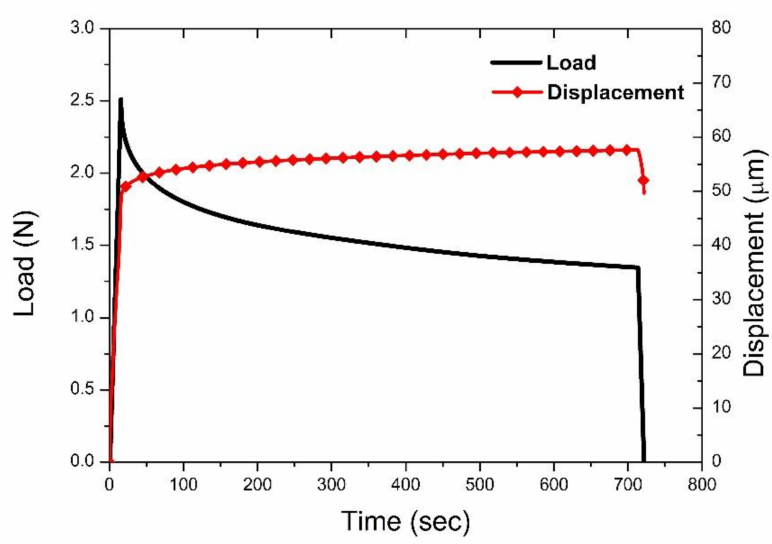
Figure 4. The load and displacement curves recorded as a function of time.